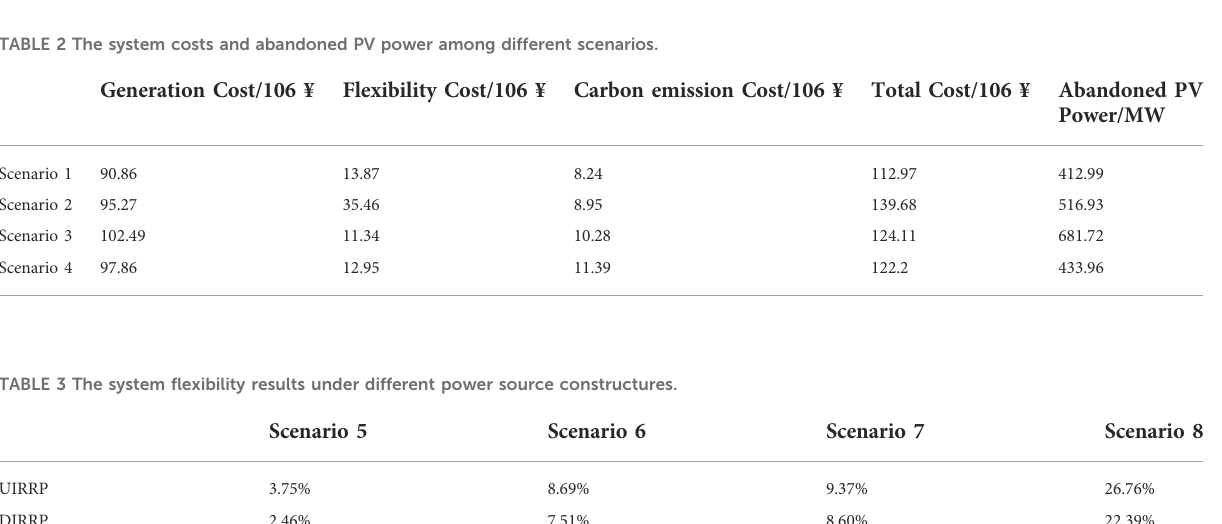
TABLE 2 The system costs and abandoned PV power among different scenarios.